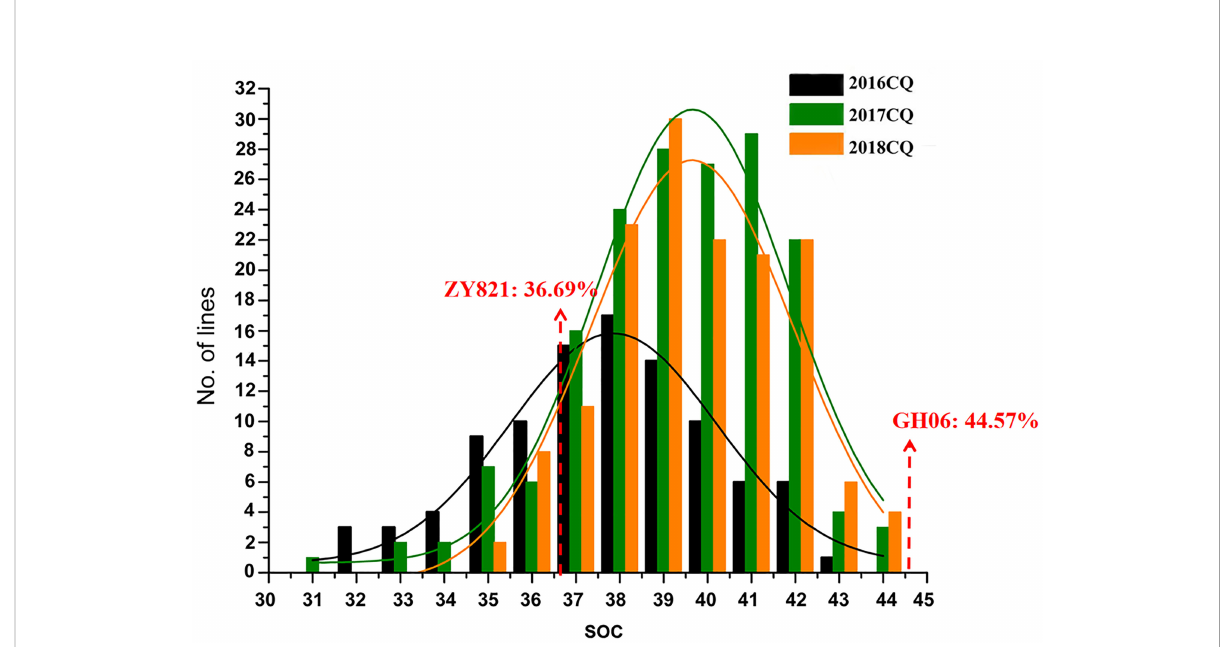
FIGURE 1 Frequency distribution of seed oil content (SOC, % of seed weight) of RIL populations in different environments. “ CQ “ refers to Chongqing and “ No. of Lines ” represents the number of